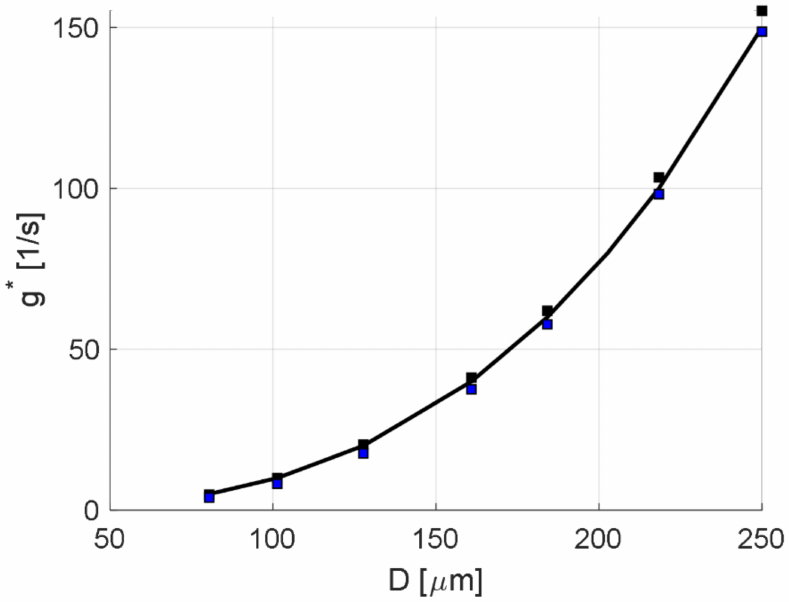
Figure 13. Case C: Inhomogeneous flow and breakup frequency ( p = 0.01). Set breakup frequency (line) compared to global estimate (square: RTD-corrected) at different drop diameters, D. Results from two flow conditions: U g = 1.5 m/s ( black ) and U g = 6.0 m/s ( blue ).